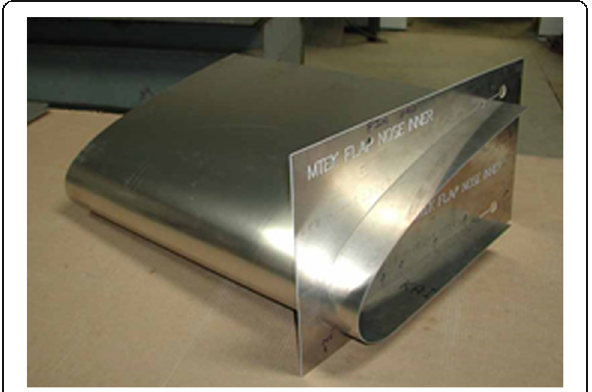
Fig. 13 The piece extracted from the tensile forming die with the length of 300 mm and depth of 165 mm